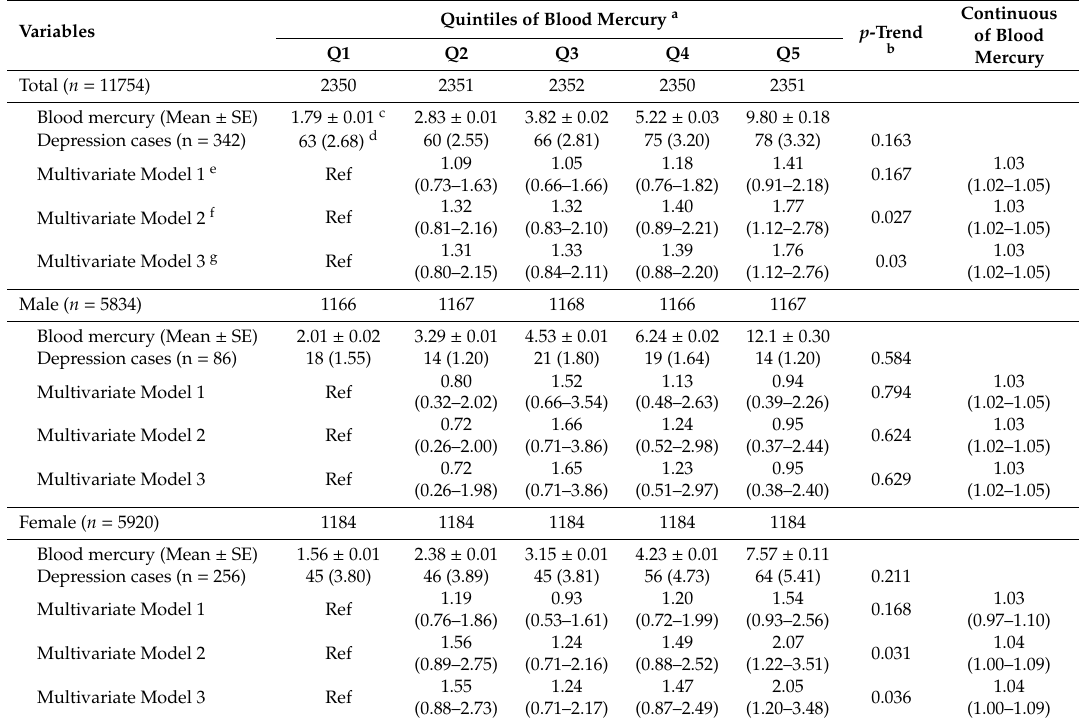
Table 2. Multivariate logistic regression for association between depression and blood mercury for all participants, KNHANES (2008–2013).